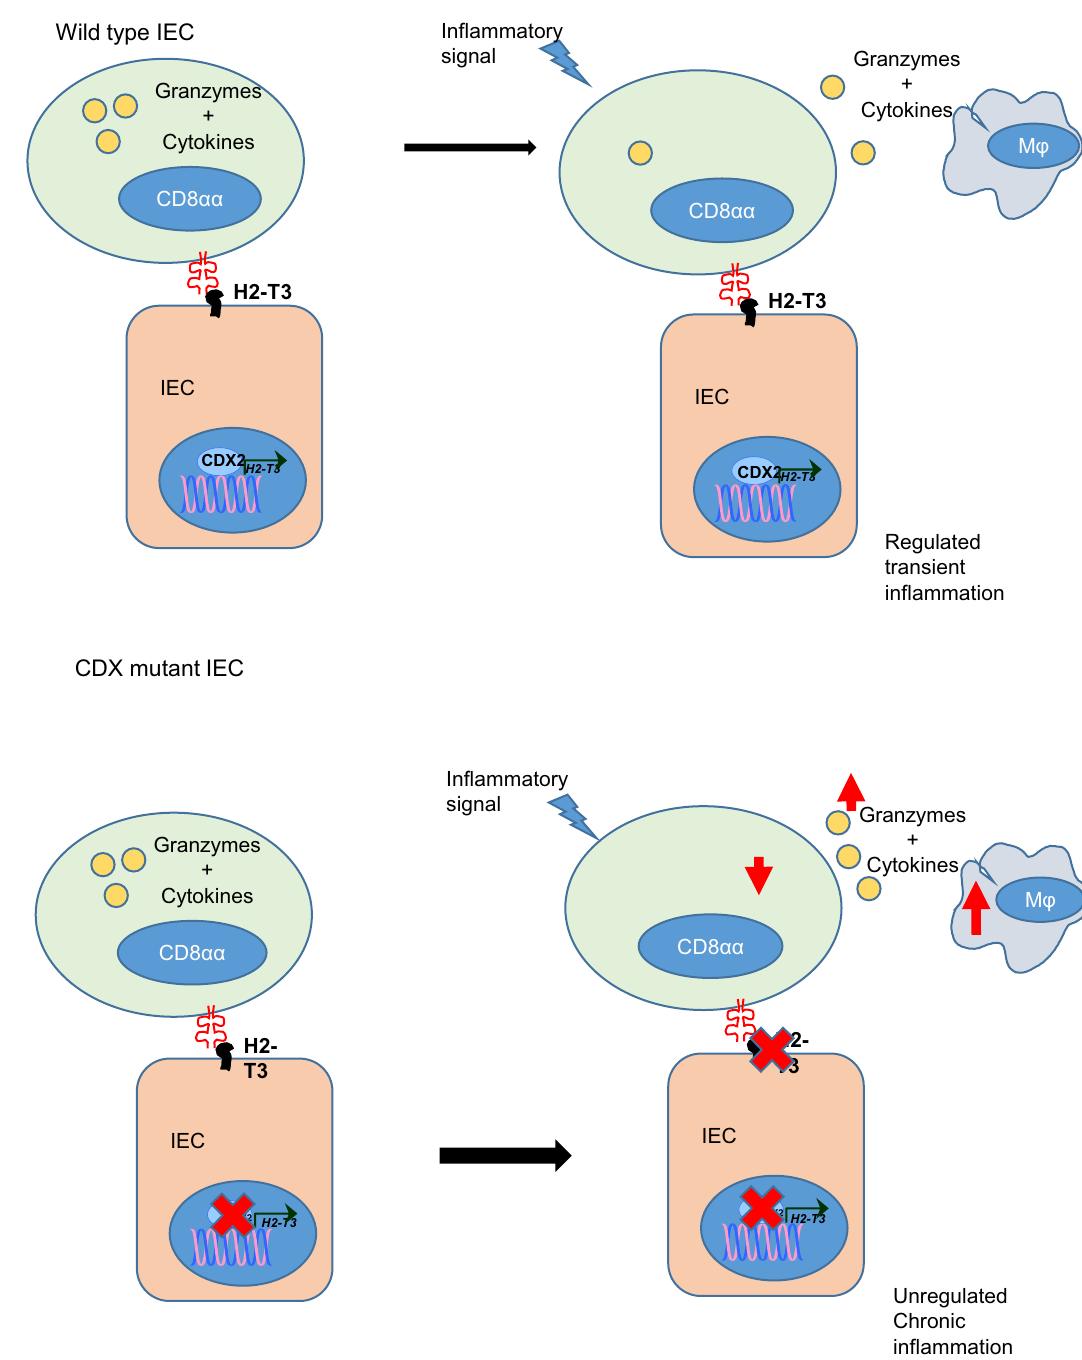
Figure 7. Proposed model of Cdx-dependent regulation of iCD8α lymphocytes. Cdx directly regulates H2-T3 which is required for retention and regulation of iCD8α T cells. The loss of H2-T3 in Cdx DKO mutants results in an increase in secretion of granzyme B from iCD8α cells potentiating the inflammatory response and promoting the migration of macrophages to the epithelial compartment. Image was produced using Microsoft PowerPoint